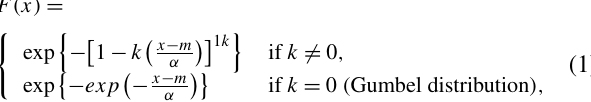
F(x) = (cid:110) (cid:40) (cid:1)(cid:3) 1 k (cid:111) if k (cid:54)= 0 , − (cid:2) 1 − k (cid:0) x − m exp α (cid:1)(cid:9) if k = 0 ( Gumbel distribution ), exp (cid:8) − exp (cid:0) − x − m α